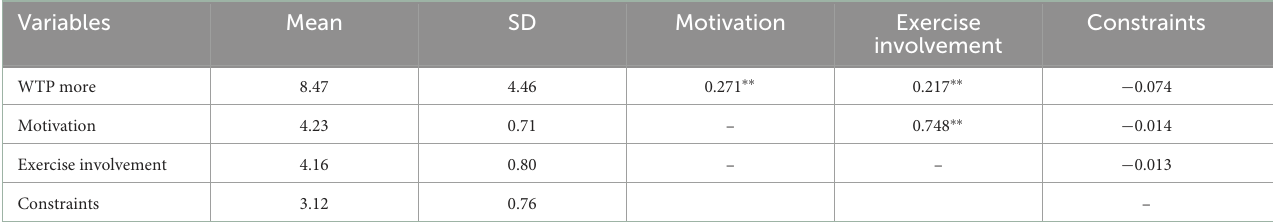
TABLE 5 Bivariate correlations between research variables and descriptive statistics.